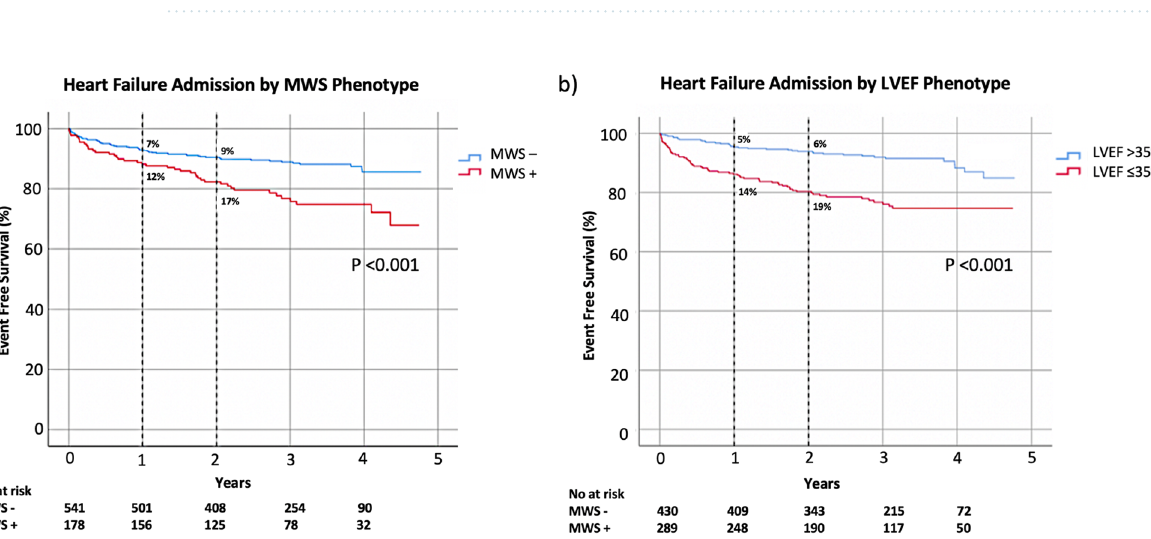
Table 2. Multivariable analysis performed for the prediction of the primary outcome. Variables included in the stepwise multivariate model include age, sex, body mass index, diabetes, hypertension, NYHA III/IV, ACE- inhibitor/ARB use, beta-blocker use, LVEF, RVEF, indexed LV mass and MWS fibrosis. NYHA New York heart association, LVEF left ventricular ejection fraction, MWS mid-wall striae.